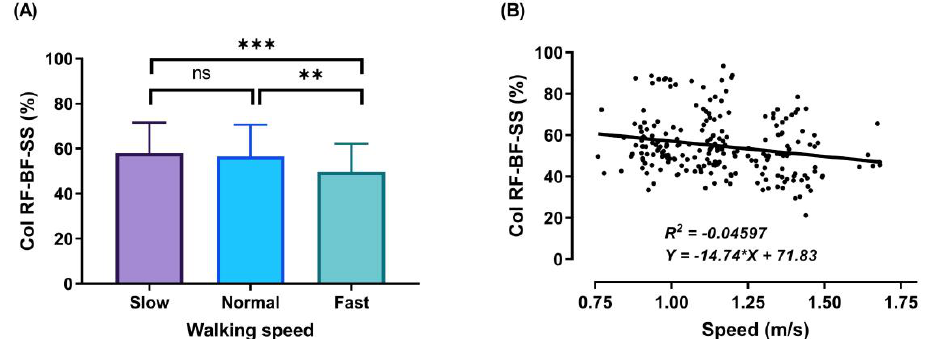
Figure 7. Mean of thigh muscles (RF-BF) co-activation at different walking speeds (slow, normal, and fast) during walking phases: SS ( A ). ANOVA results showing the effects of changing in CoI of thigh muscles during walking speed (slow, normal, and fast). Correlation between walking speed and thigh muscles (RF-BF) co-activation during SS walking phase ( B ). Asterisk signs above the line represent significant differences between walking speed: (***) indicates p ˂ 0.001, (**) indicates p ˂ 0.01, and (ns) indicates non-significant.